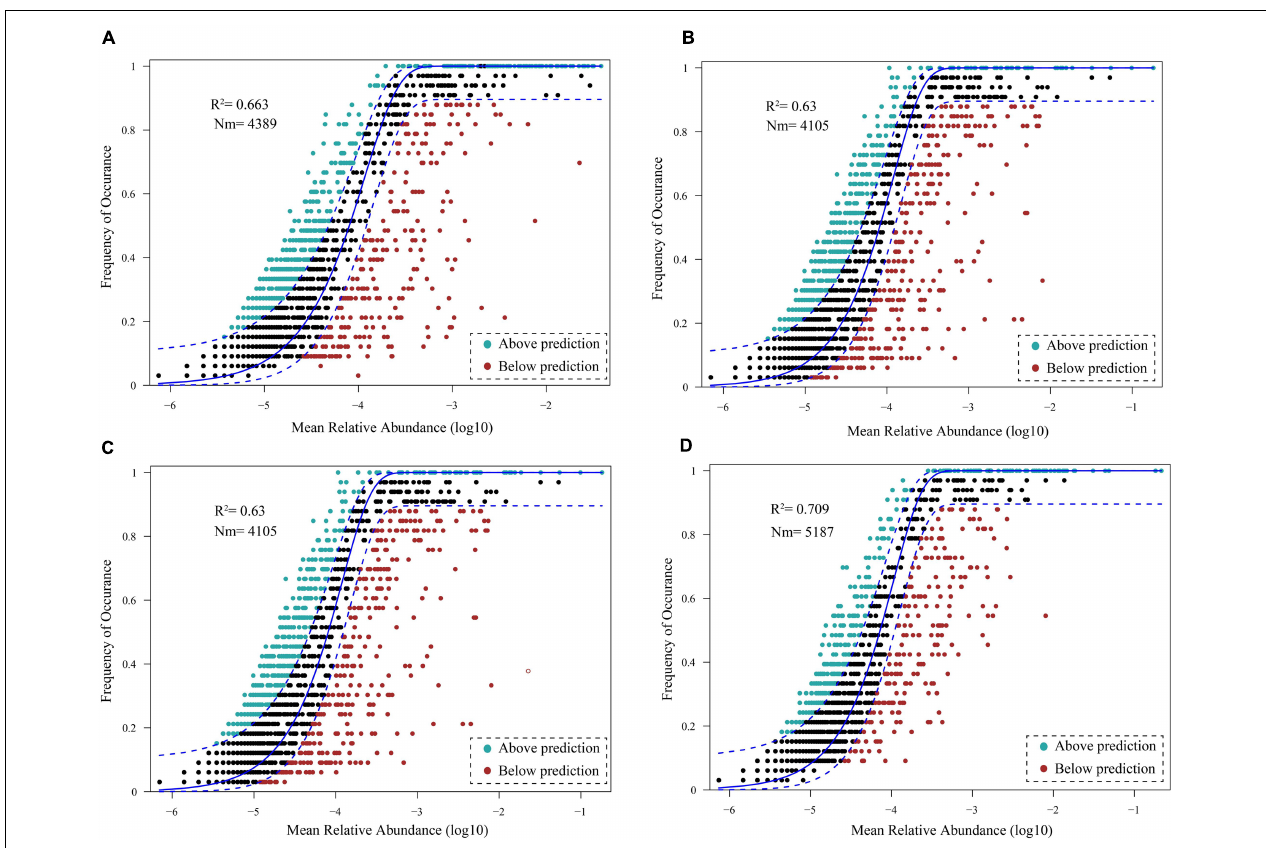
FIGURE 8 | Fit of the neutral community model (NCM) of 2018S (A) , 2018A (B) , 2019S (C) , 2019A (D) bacterioplankton community